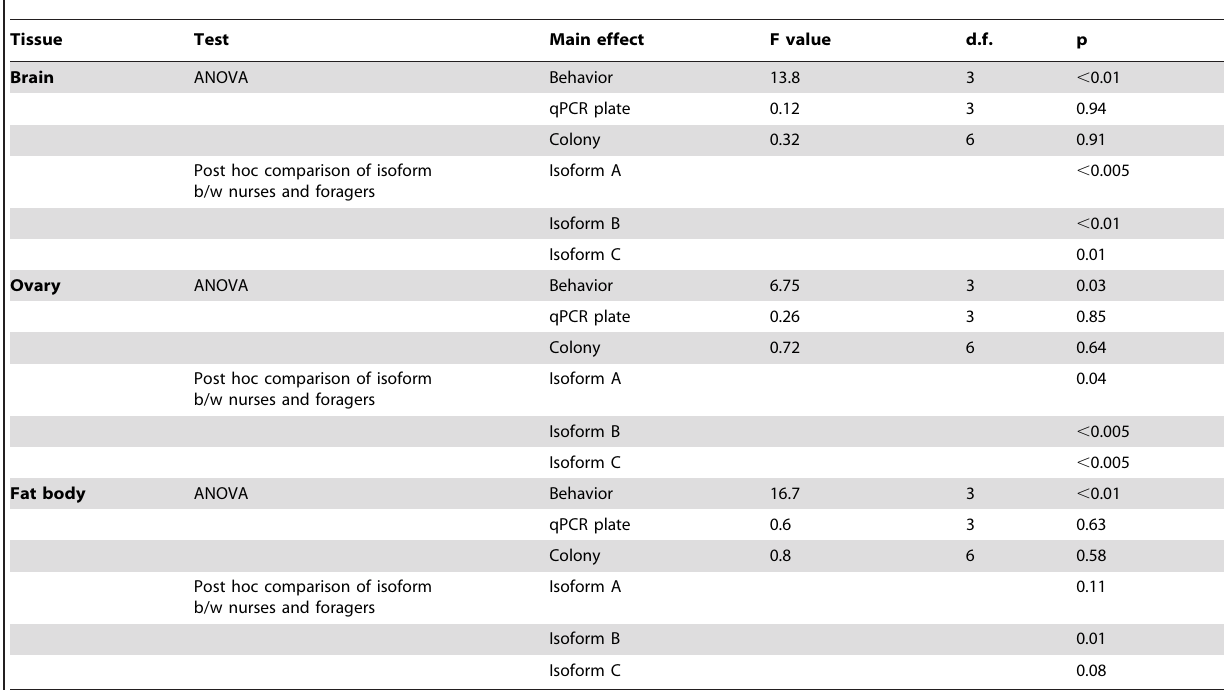
Table 1 . Statistical analysis using main effects ANOVA.